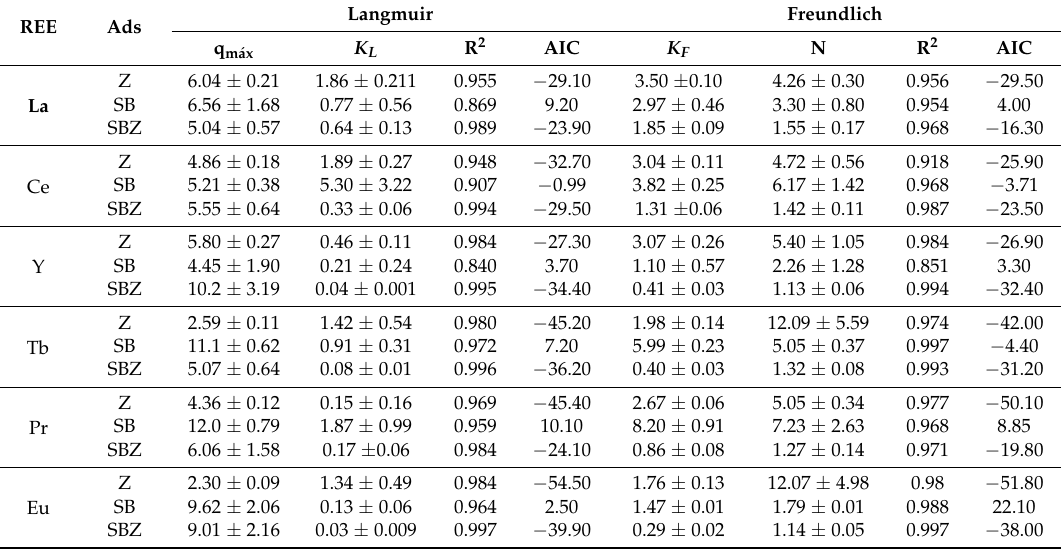
Table 9. Langmuir and Freundlich isotherm fittings for multi-solute solutions in different adsorbents (Ads): zeolite (z), suspended biomass (SB) and supported biomass on zeolite